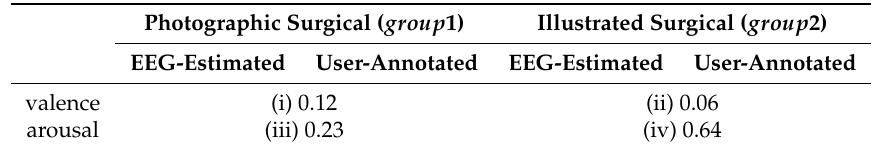
Table 6. Cohen’s d values to measure the difference of the emotional reaction estimation methods: EEG-biosignal and user-annotation.